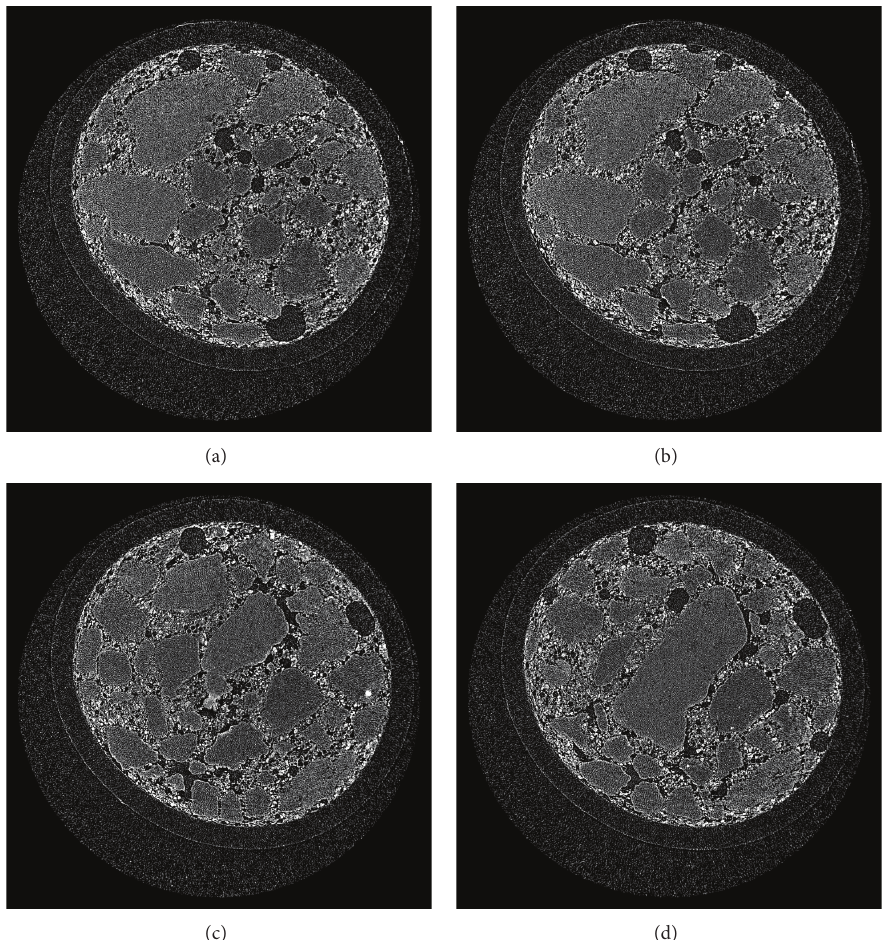
Figure 3: 8-bit micro CT cross-sectional images of insulating concrete (1,500 images are obtained along the length direction: (a) 100th image, (b) 138th image, (c) 400th image, and (d) 500th image).